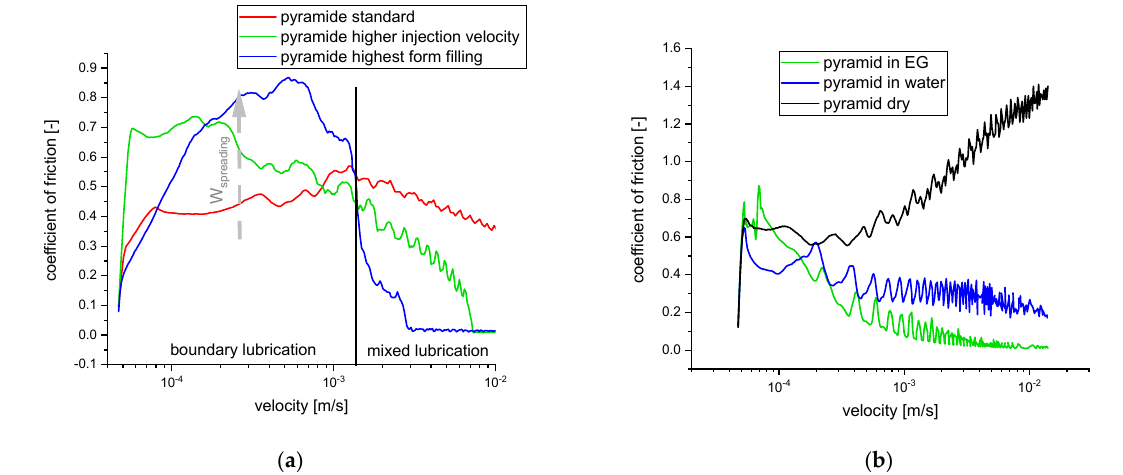
Figure 9. ( a ) Measurements of Stribeck-type velocity sweep measurements on early pyramid structures for characterization of friction regimes in ethylene glycol (EG) for different molding parameters: standard (red), higher injection velocity (green) and highest form-filling (blue) parameter. ( b ) Velocity-dependent behavior of friction for dry (black) low-viscosity lubrication (blue: water) and medium-viscosity lubrication (green: ethylene glycol). For this standard molding procedure, a comparison of the Stribeck curves for the dry condition and different viscous lubricants (Figure 9b; water and EG) shows (1) that at low speeds, an increase in friction compared to the dry condition is avoided if, at the lower viscosity of water, an effectively increased structural fraction in the contact reduces the forced wetting of LSR with the lubricant, and (2) that at increased velocity for the greater viscosity of ethylene glycol, friction reduction due to film formation occurs earlier.